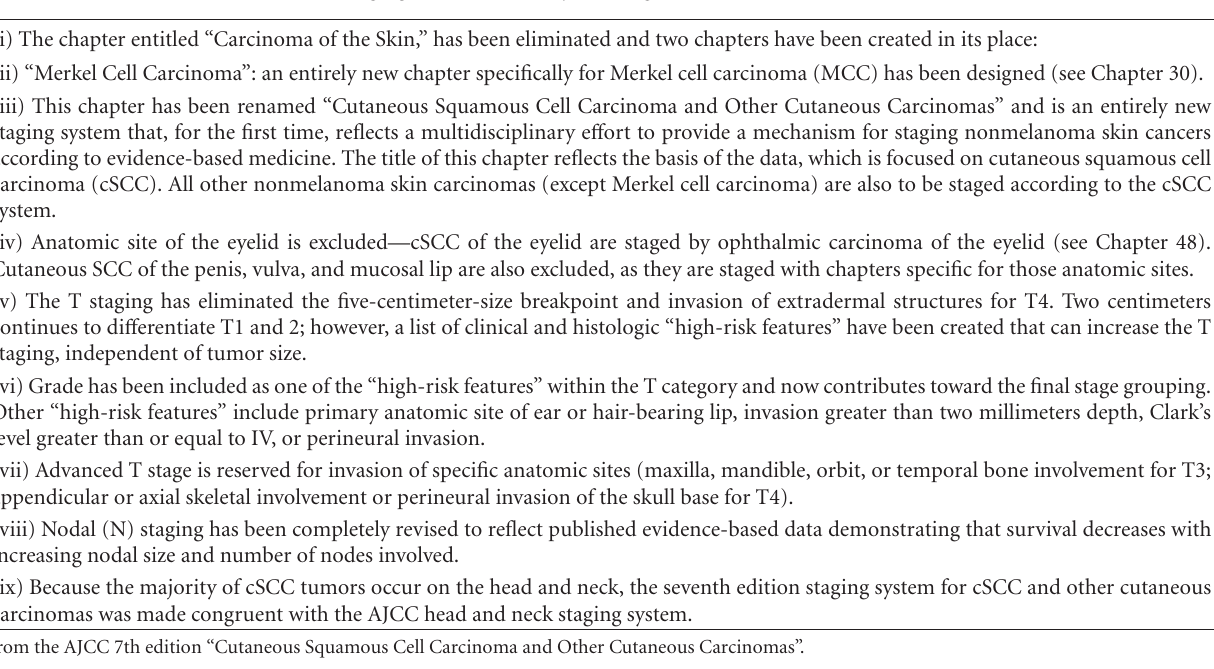
Table 1: AJCC cancer staging manual summary of changes from the sixth edition to the seventh